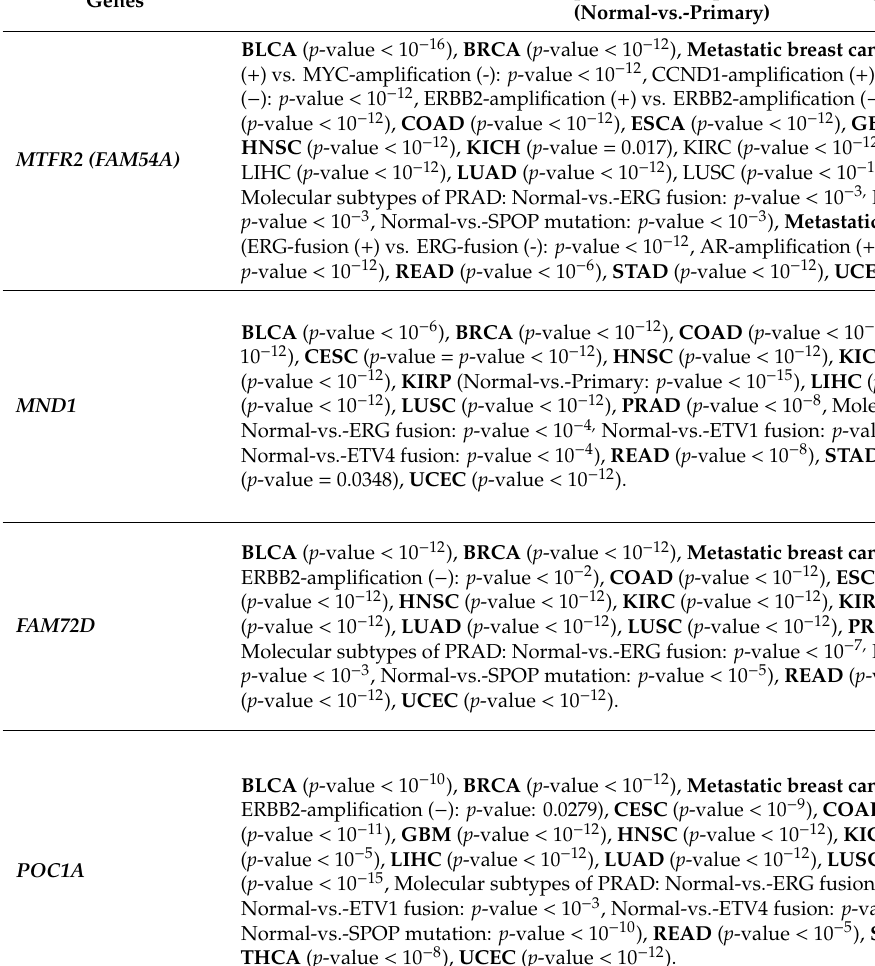
OS (Higher Expression Levels-vs.-Lower Expression